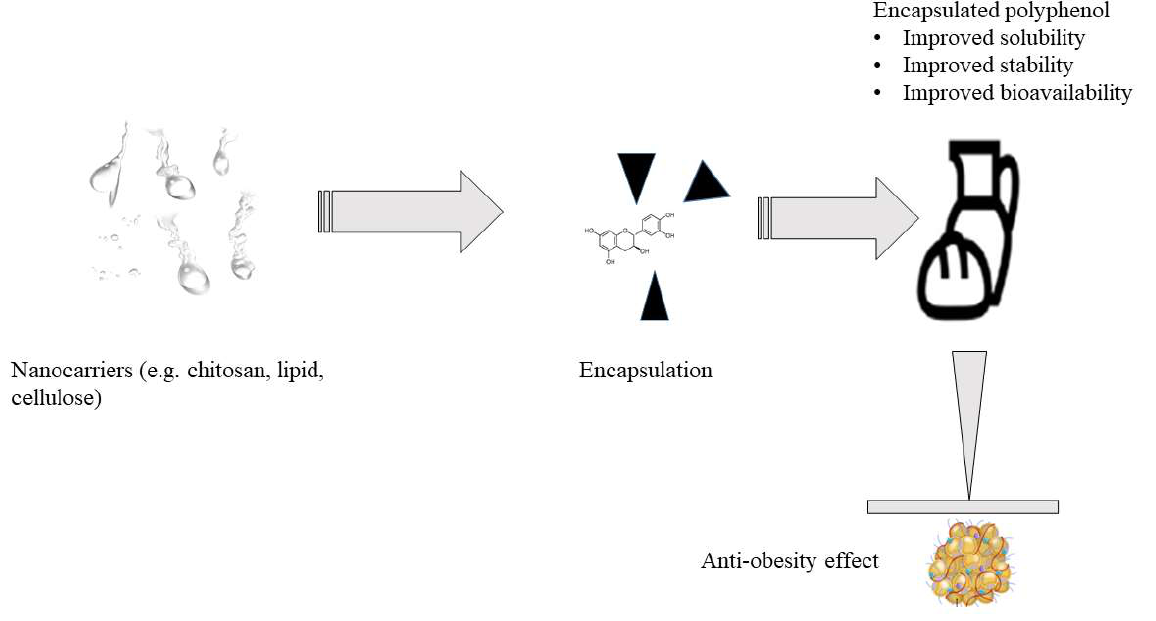
Figure 7. Proposed encapsulation process of polyphenols .